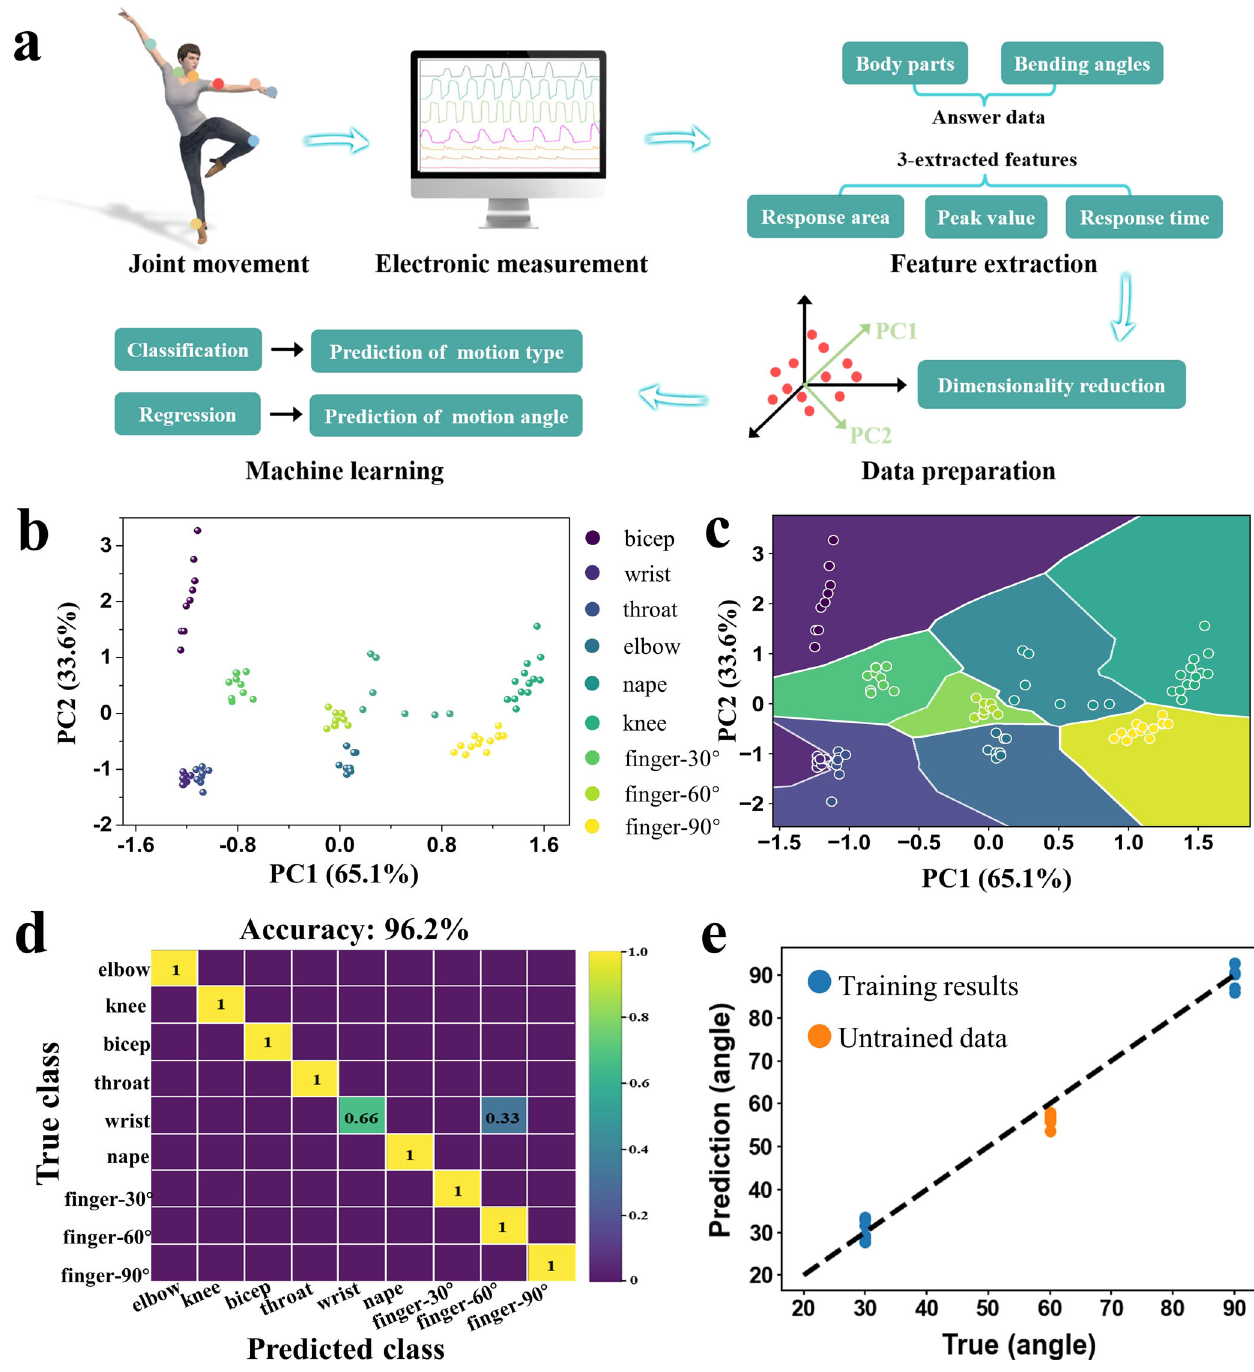
Fig. 6 Human motion prediction. a Schematic illustration of the data preparation for principal component analysis (PCA)-assisted classi fi cation. b PCA scatter plot of nine types of joint motions. c Decision map of nine groups classi fi ed by applying a k-nearest neighbor (KNN) of ML model with K -fold validation ( K = 2). d Confusion matrix of nine joint motions from KNN classi fi cation results. e Predicted fi nger bending versus the actual bending